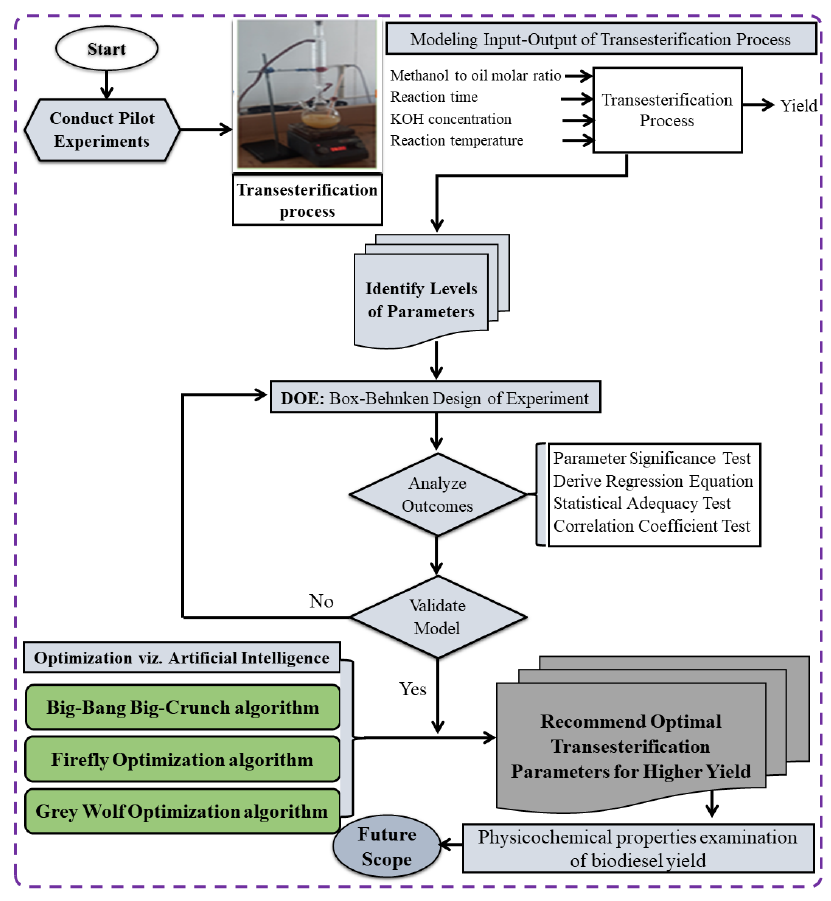
Figure 2. Framework for modeling and optimization for higher biodiesel yield. Table 2. Transesterification parameters and operating levels.